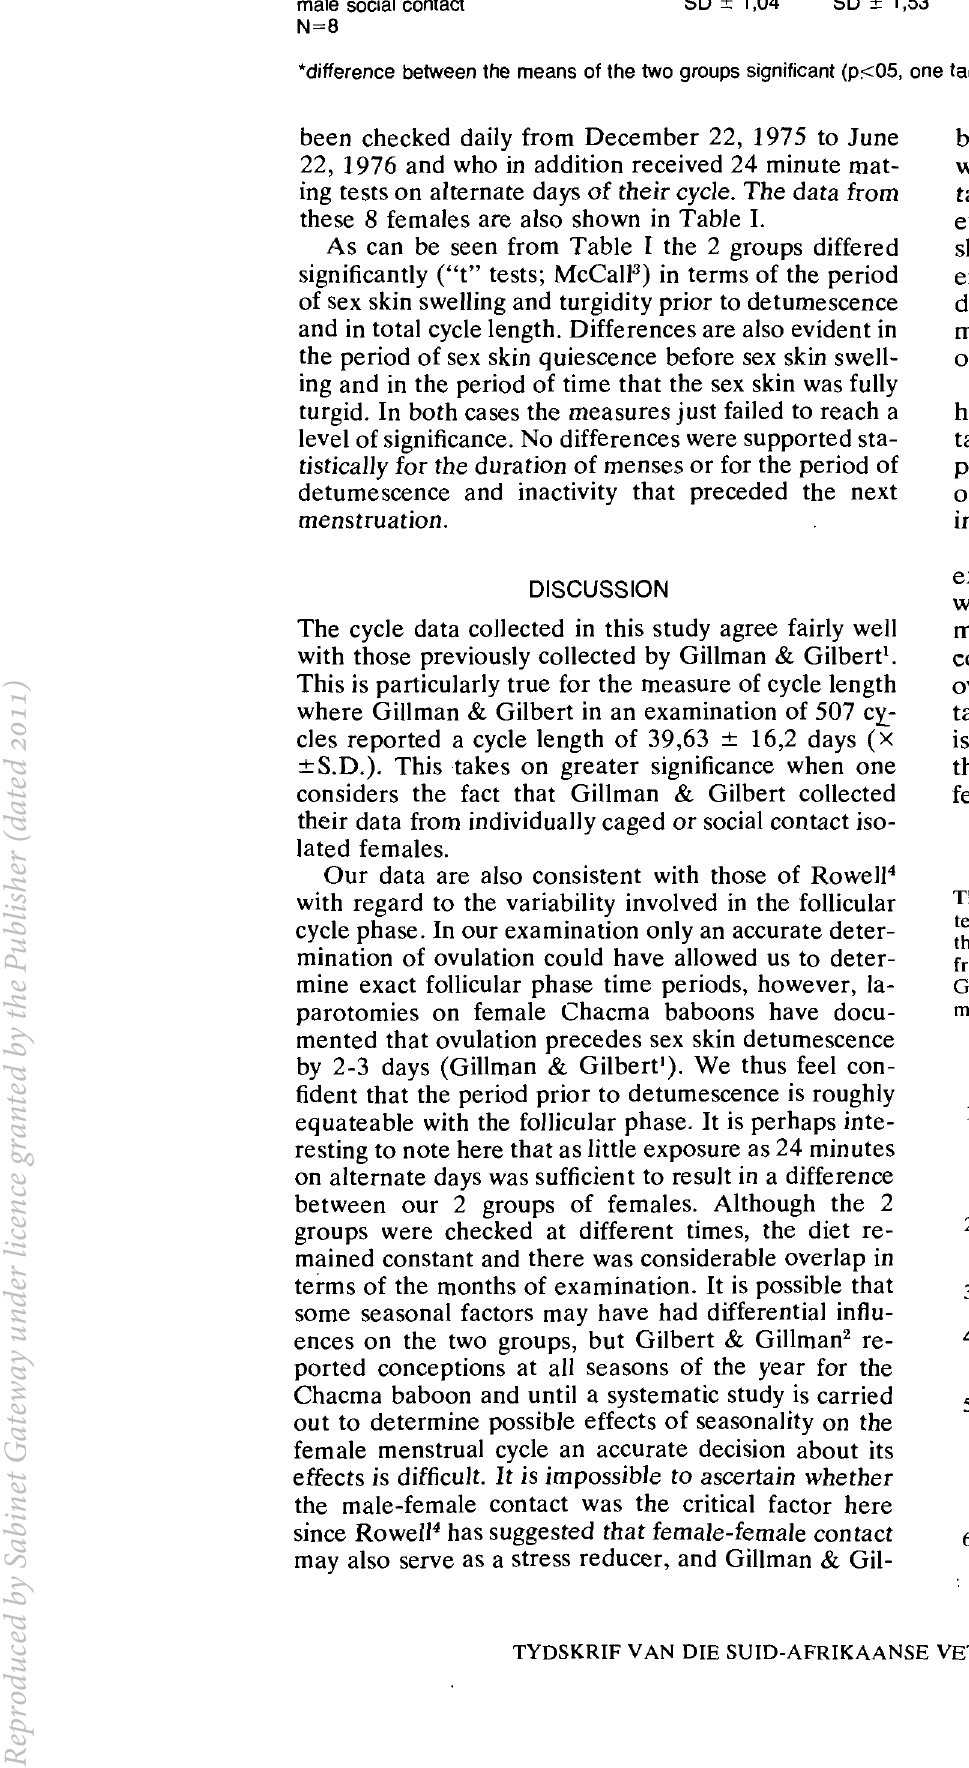
Table 1: MENSTRUAL CYCLE DATA ON INDIVIDUALLY CAGED FEMALE BABOONS Number of Duration Period of quies- Period Period prior Period from Cycle Cycles of menses cence before sex fully to sex skin detumescence length examined for in skin swelling turgid detumescence to next menses in each female days in days in days in days in days days x Females denied x = 2,93 = 3,35 N=16 Females